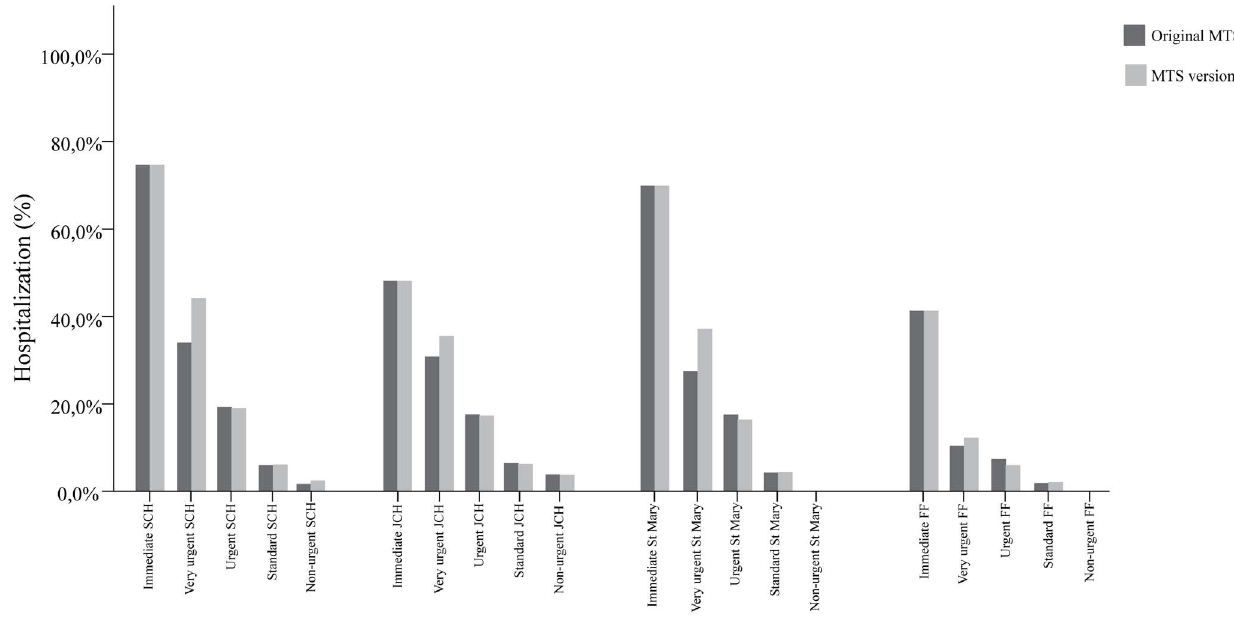
Figure 1. Percentages of hospitalization per urgency level in Sophia Children’s Hospital (SCH), Juliana’s Children’s Hospital (JCH), St Mary Hospital, and in Fernando Fonseca Hospital (FF).